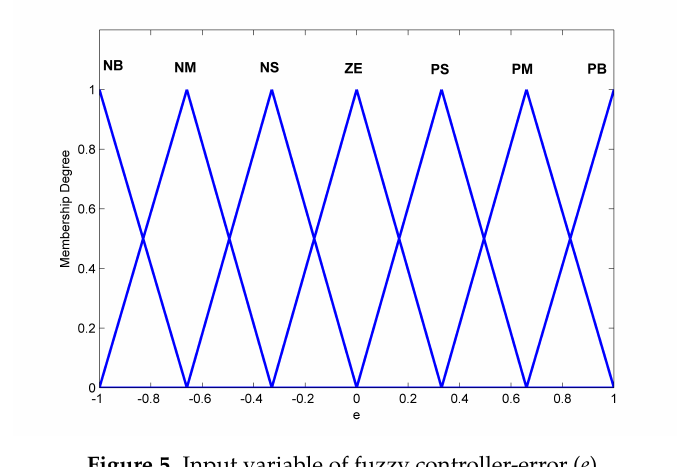
Figure 5. Input variable of fuzzy controller-error ( e ).